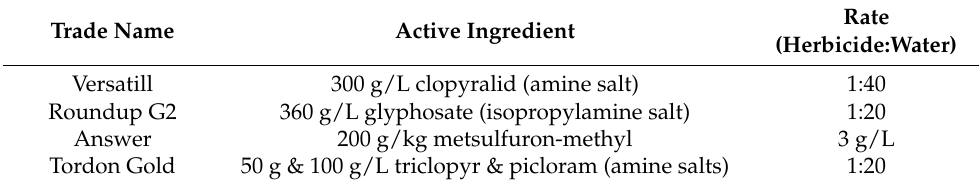
Table 1. The herbicides and rates used for the experiment.